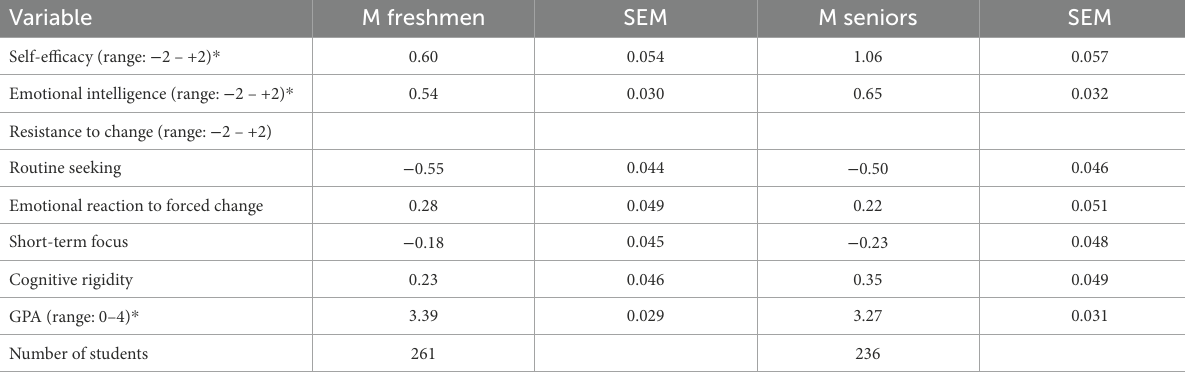
TABLE 1 Descriptive statistics including mean (M) and standard error of the mean